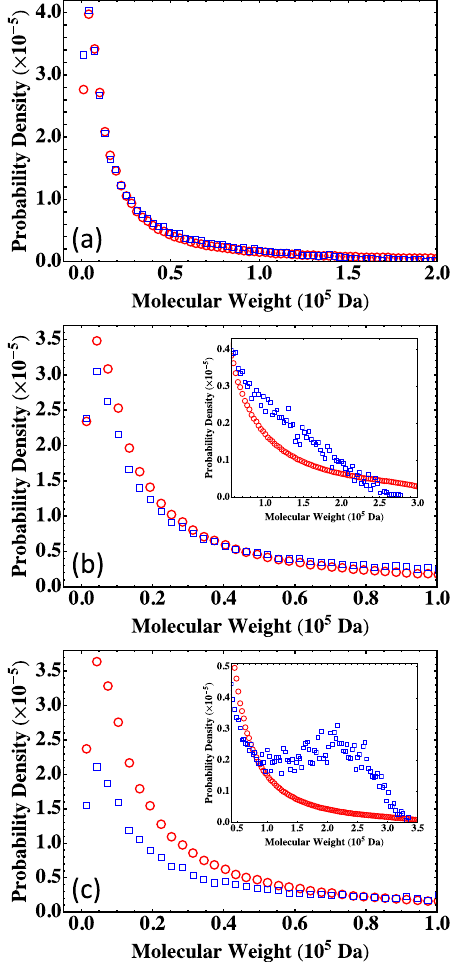
Figure 9. MWD for the three systems in Table 5: ( a ) S n < , ( b ) S n (cid:39) , and ( c ) S n > . The results are for the Flory-Stockmayer theory (red circles) and the MC simulations (blue squares). The MC results are the averages of 5000